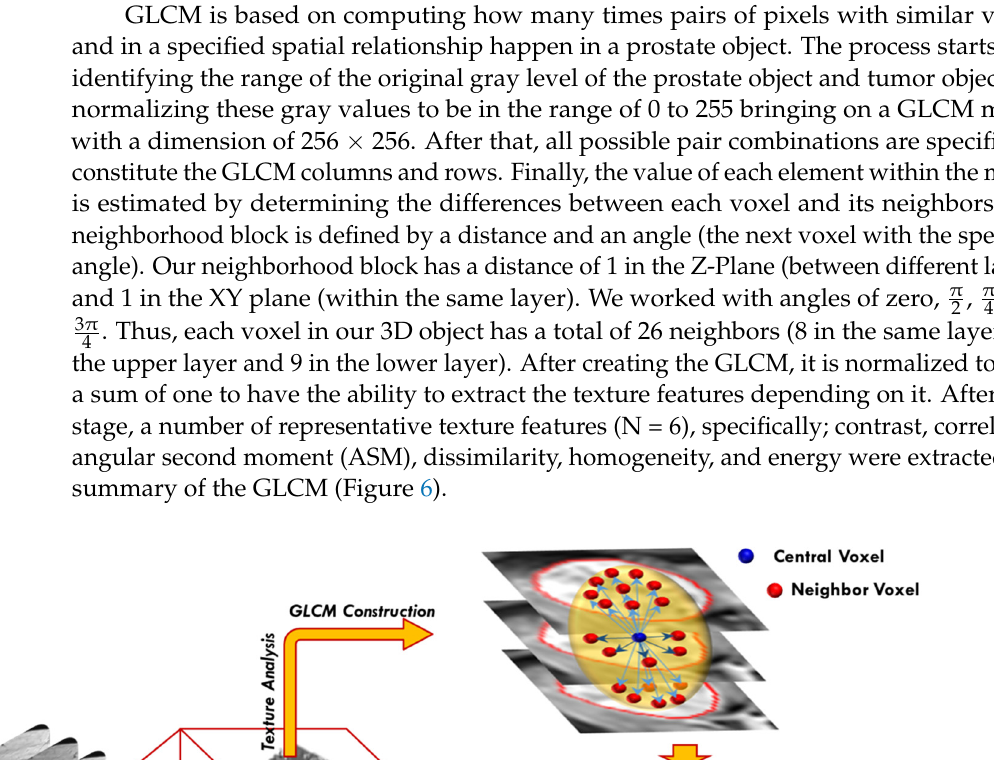
. , (cid:2976) , and (cid:2871)(cid:2976) , π , and 3 π (cid:2870) (cid:2872) (cid:2872) 2 4 4